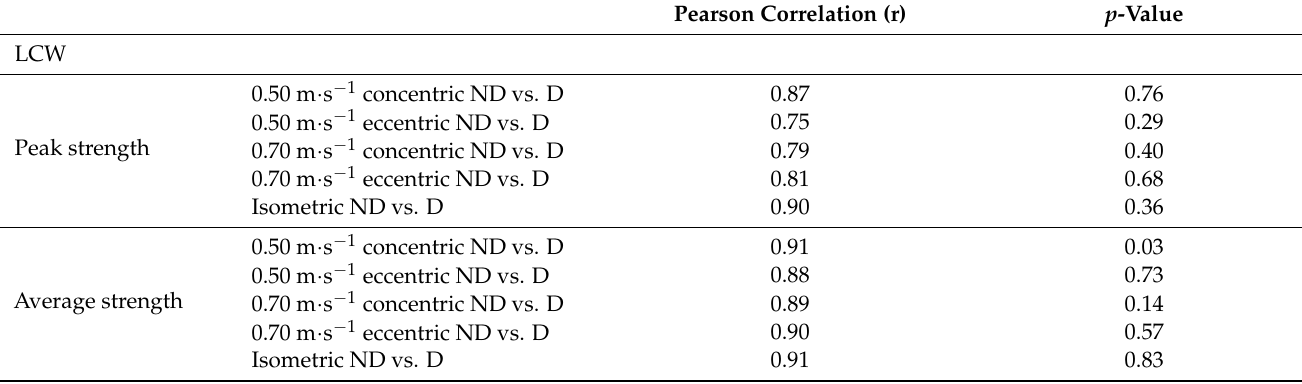
Table 5. Correlation (r) and significant differences ( p value) for dominant and non-dominant sides on two trunk rotator